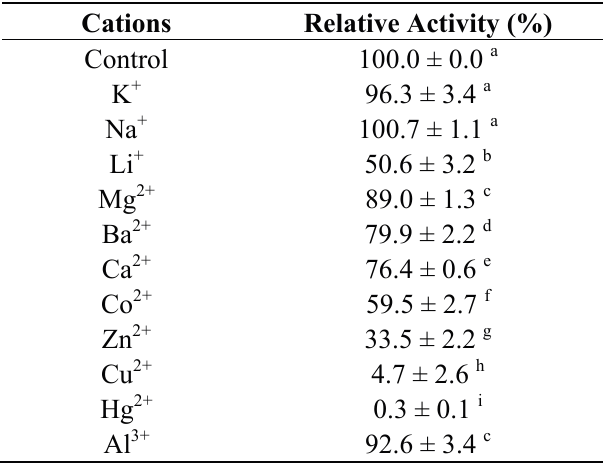
Table 2. Effect of cations on the activity of Bentong ginger protease. The same letter indicates not significantly different at p ≤ 0.05.